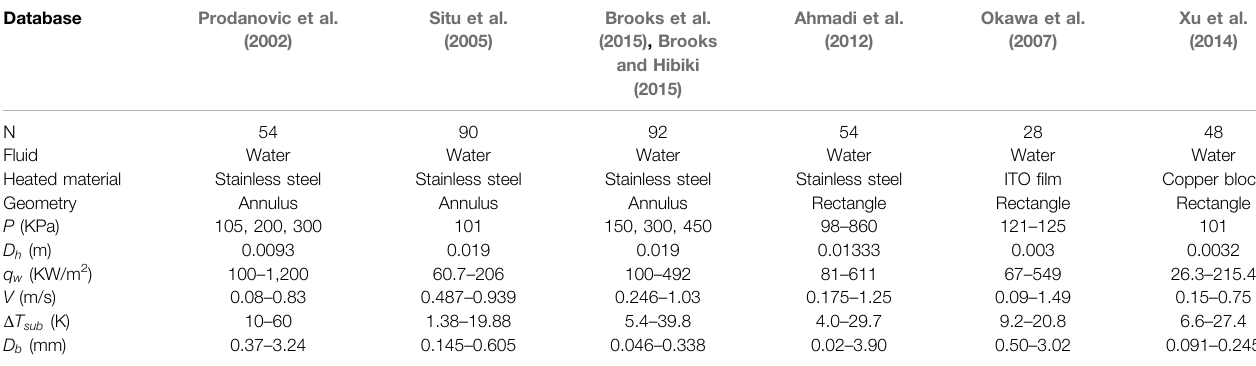
TABLE 1 | Experimental databases for the